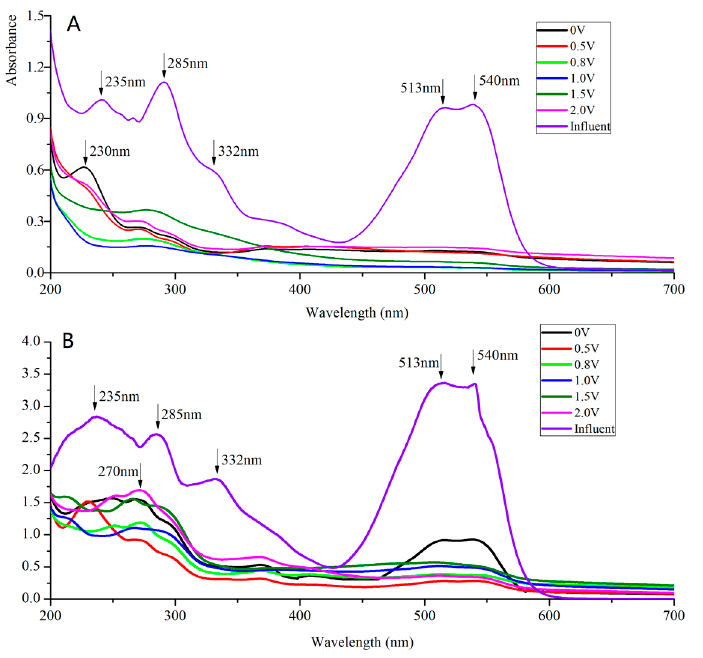
Figure 4. The UV-vis spectrum of the influent and the effluent under different external voltages ( A ) the influent X-3B = 200 mg/L and ( B ) the influent X-3B = 800 mg/L.